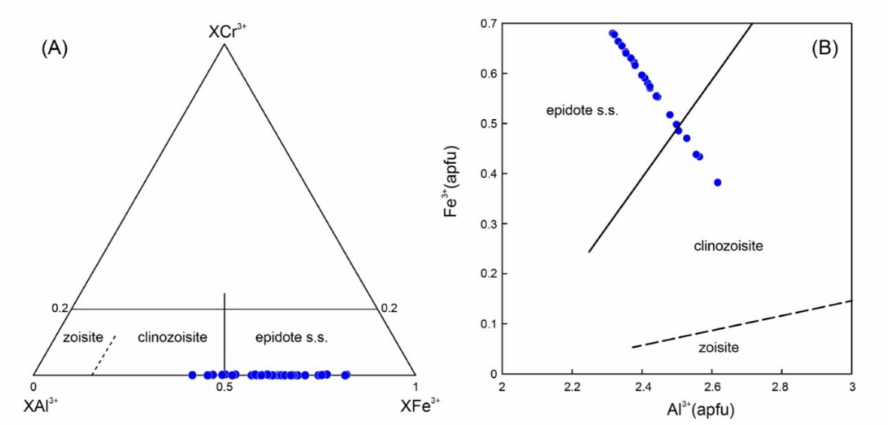
Figure 12. Epidote classification diagrams. Ternary diagram based on XAl 3+ –Xfe 3+ –XCr 3+ (adopted from [21]) ( A ); and Al 3+ vs. Fe 3+ diagram ( B ).